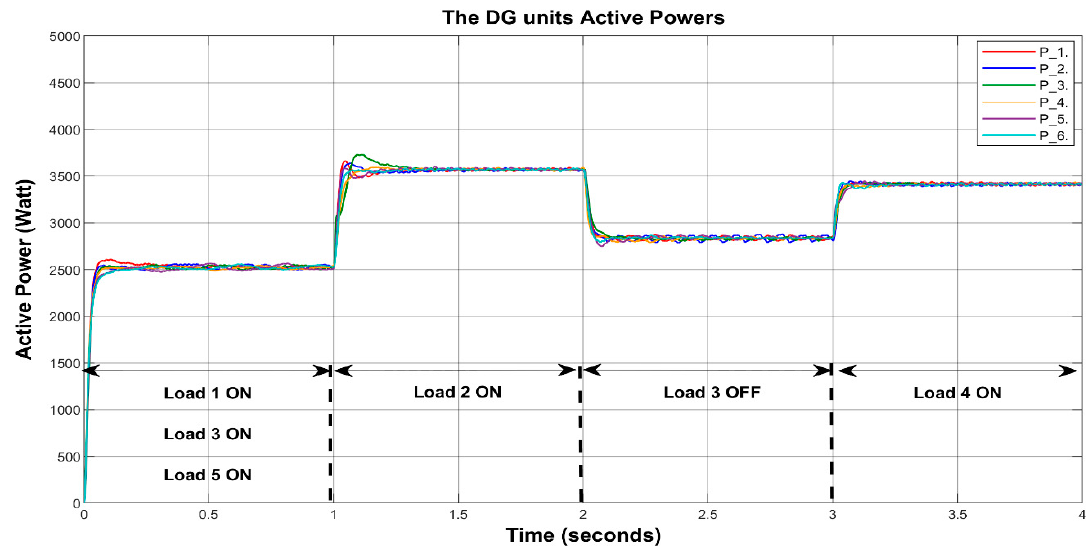
Figure 13. The DG units’ frequencies for Case 2.